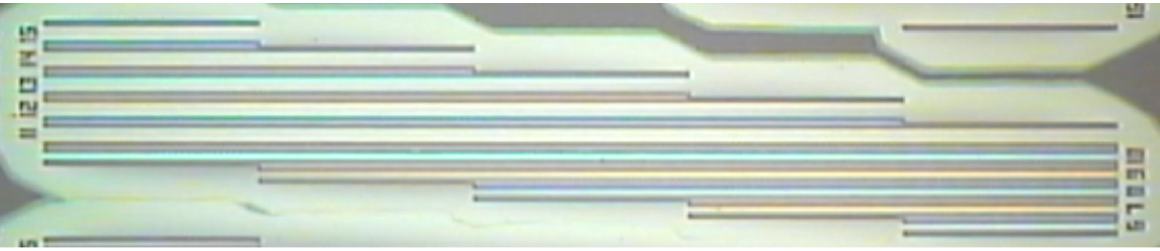
Figure 9. Array of double clamped beams with length variable from 200 µm to 1000 µm ( Δ L = 200 µm).